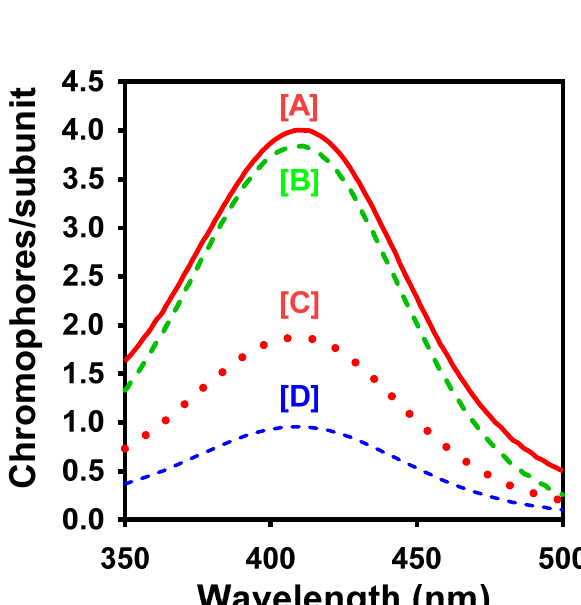
Figure 4. ( A – C ) Temporal relationship between GAPDH H 2 O 2 irreversible inactivation, subunit unfolding, NAD + dissociation, and aggregation: ( A ) Kinetic plots of DTNB reactivity with native p − GAPDH at 14 °C by DTNB oxidation of C c (SH) ( k α obs ), C c (SS)C v disulfide formation ( k β obs ), and DTNB oxidation of the two downstream cysteines following subunit unfolding ( k γ obs ). ( B ) Kinetic plot of DTNB reacting with the single cysteine residue exposed after subunit unfolding in H 2 O 2 − oxidized r − GAPDH subunits at 14 °C. ( C ) Binding stoichiometry of cysteinylthionitrobenzoate adducts to r − GAPDH subunits after incubation with DTNB and SDS − denaturation and SCBE in DTT buffer, as measured by TNB release. [A] TNB release from native p − GAPDH. [B] TNB released from SDS − denatured H 2 O 2 − oxidized r − GAPDH after a 3 h incubation in the denaturing DTNB bu ff er ( cf Figure 1c). [C] TNB released from p − GAPDH after completion of the DTNB oxidation kinetic experiment in panel ( A ) for a total extra incubation of 3 h. [D] TNB release after a sample of pre − H 2 O 2 − oxidized r − GAPDH after completion of the DTNB oxidation kinetic experiment in panel ( B ) for a total extra incubation of 3 h. Following measurement of the TNB binding stoichiometry, the values of k γ obs and k δ obs could then be calculated.